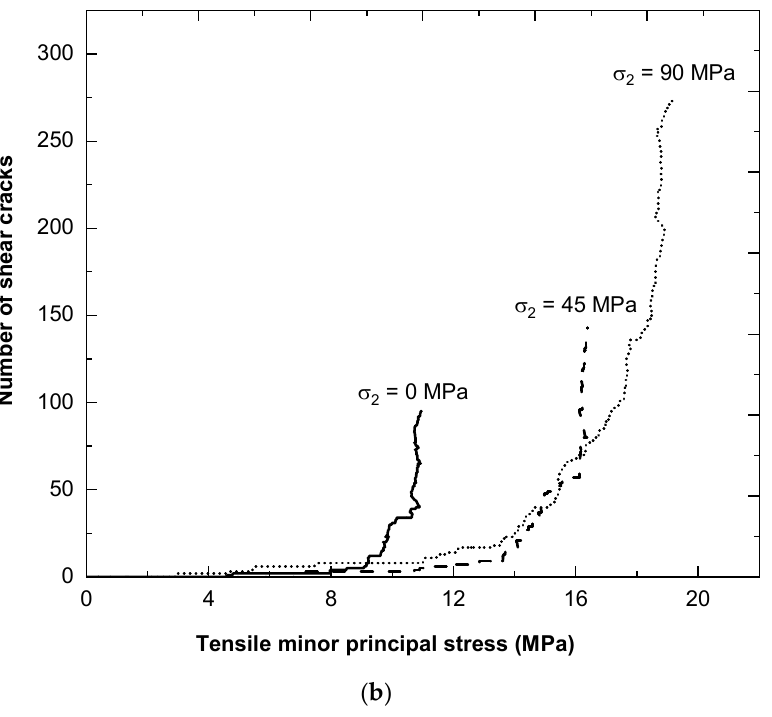
Figure 17. Comparison of crack formation in the numerical sample with an increase in σ 2 : ( a ) tensile cracks and ( b ) shear cracks. In all cases, σ 1 was kept constant at 90 MPa.